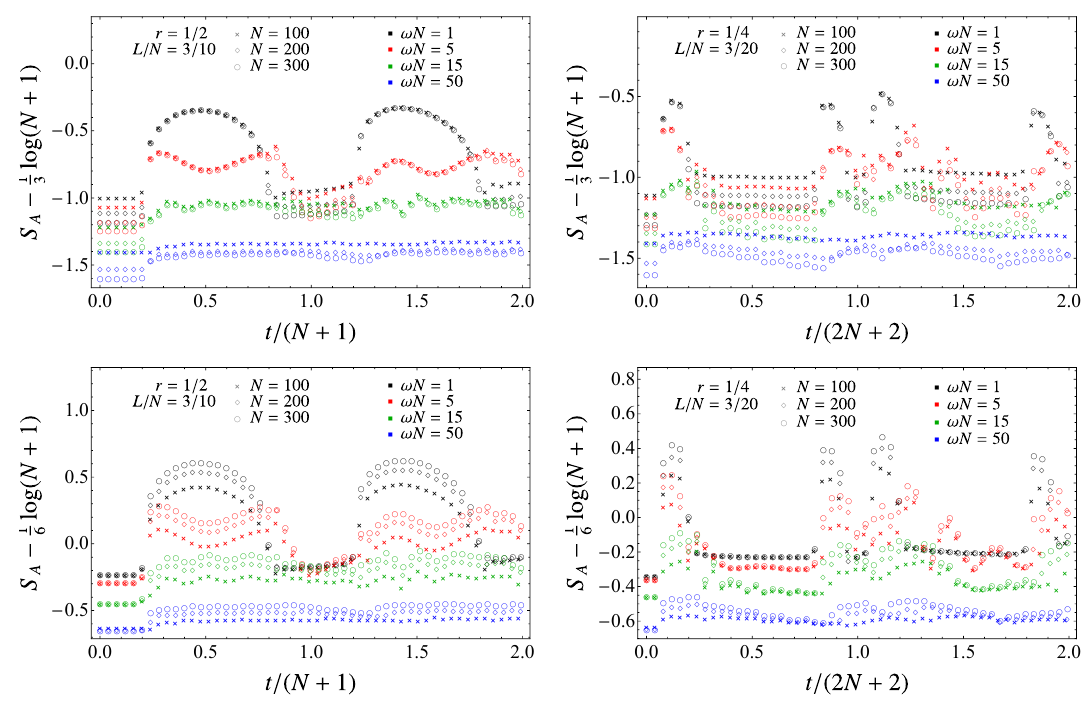
Figure 13 . Temporal evolution of the entanglement entropy S A in the setup described either in figure 11 (left panels) or in figure 12 (right